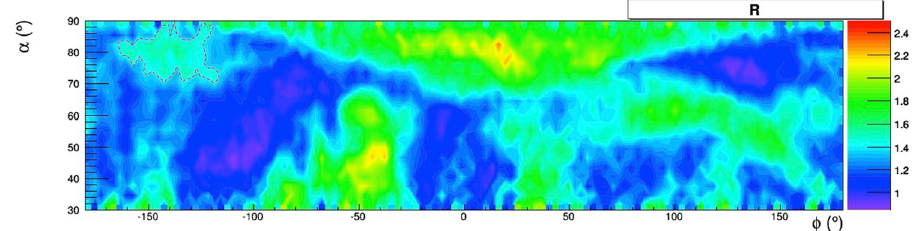
Figure 20. A structure evidenced by the muographic image and with contour shown by a dashed line, without any correspondence among the known structures. The drawing was obtained using the software root